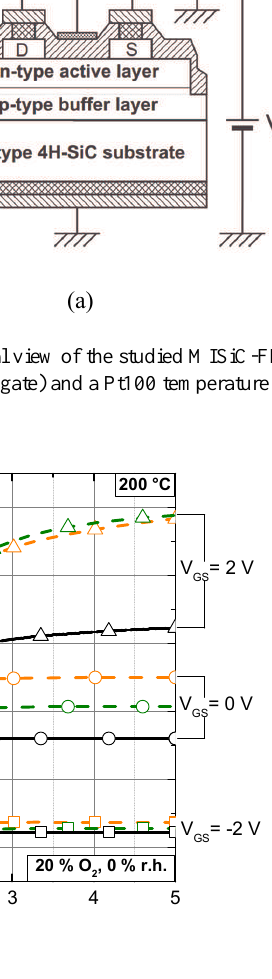
Figure 2. Typical IV curves of the sensor in air (black) and test gases. The sensitivity towards ammonia (orange, dashed) and CO (green, dashed) changes nonlinearly with the applied gate potential, which can either be used to maximize the sensor response for one distinct gas or to identify a gas by a gate bias sweep.